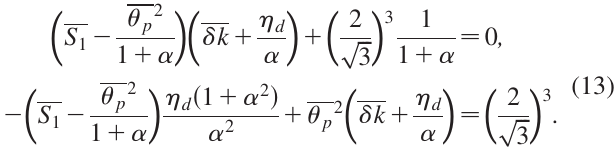
¼ 0 . , (cid:5) p (cid:3)